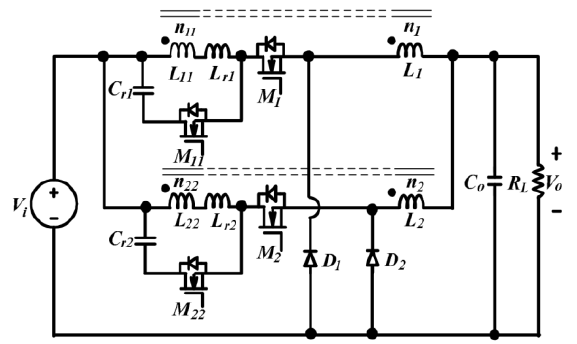
Fig. 10. Interleaved coupled-buck converter with active-clamp circuits [15]. Fig. 11. IBC with extended duty cycle [16].